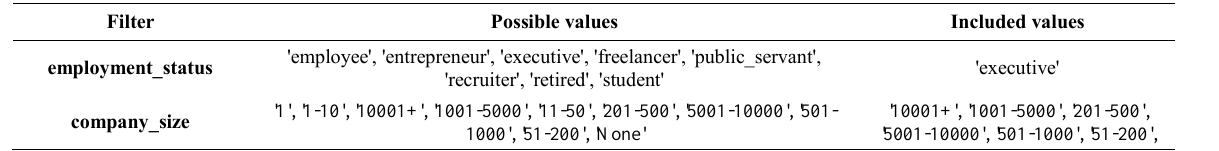
Table 3. Filter conditions for